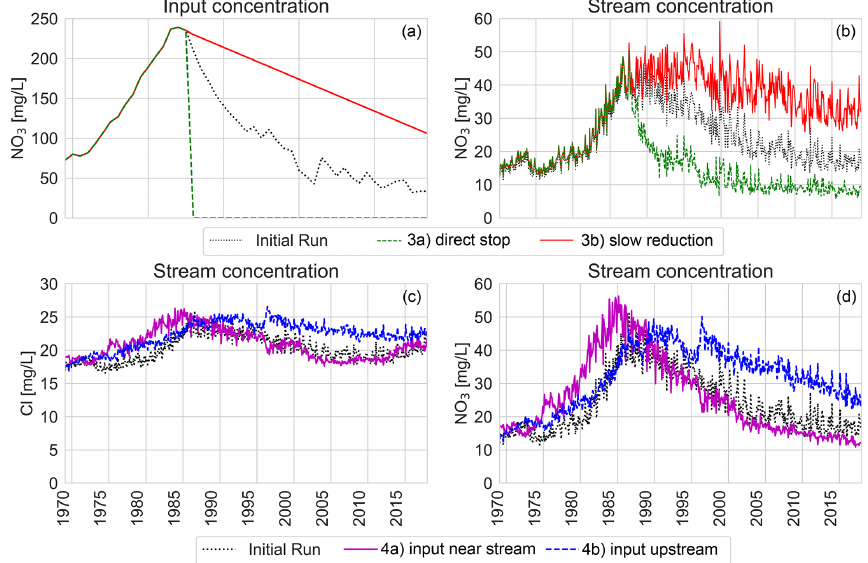
Figure 6. Panels (a) and (b) show the effect of two scenarios with changes in the nitrate input for the upstream of the catchment. Note the difference in the scale of the y axis between the left and right panels. Panels (c) and (d) show the effect of spatial changes in land use on both chloride (c) and nitrate (d) , i.e. only agriculture inside of a 200m strip around the stream (4a) and only agriculture outside of the same buffer strip (4b). In both scenarios, agricultural parts have 50% agriculture and 50% nature, so that the total fraction of fields is approximately equal to that in the real